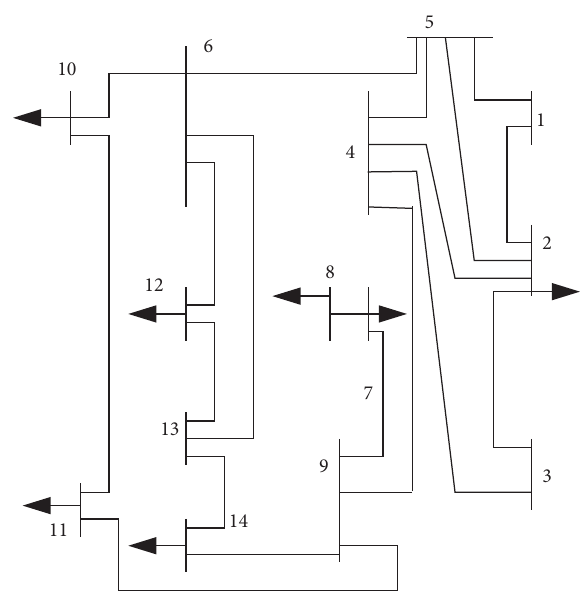
Figure 2: IEEE 14 node system wiring